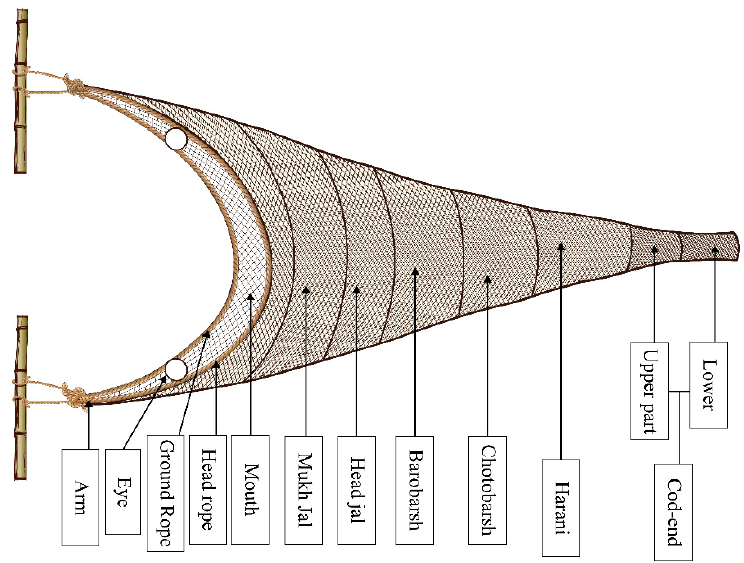
Figure 2. Set bag net, the predominant gear used by the fishers to catch Bombay duck.